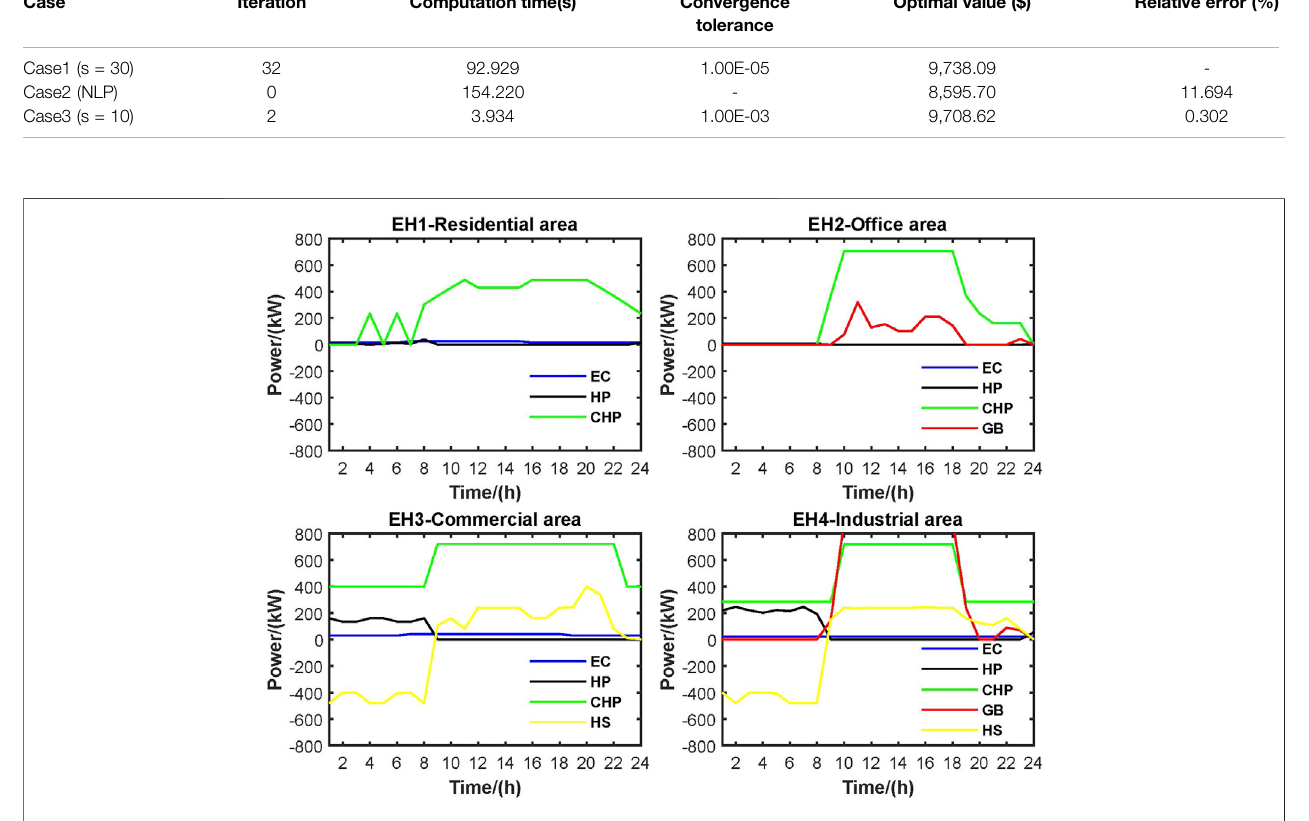
FIGURE 8 | Operation states of energy converters of four regional